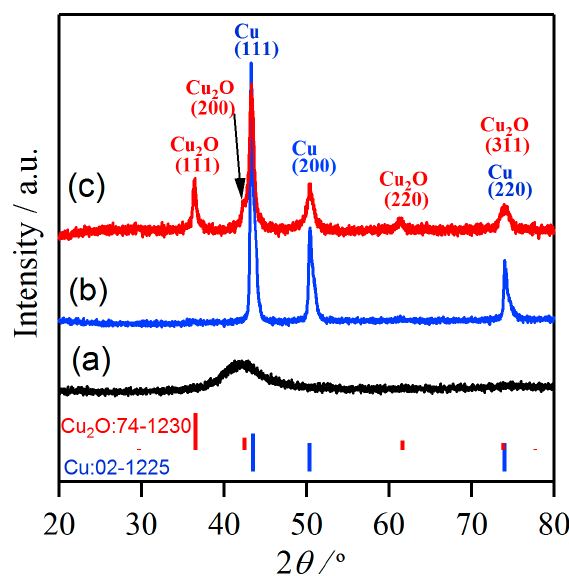
Figure 1. X-ray diffractometor (XRD) patterns of as-spun Ti 40 Cu 60 ribbons ( a ), nanoporous Cu after dealloying in 0.03 M HF solution at 348 K ( b ) and nanoporous Cu after an immersion treatment in anhydrous ethanol for 72 h ( c ).